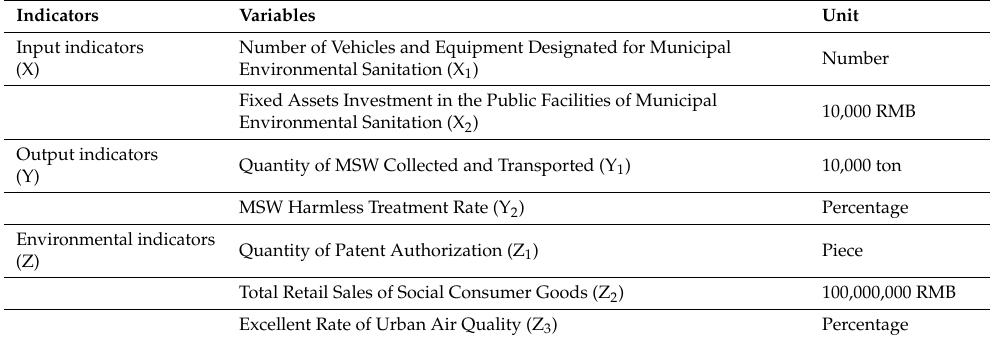
Table 1. Indicator system for measuring the efficiency of municipal solid waste (MSW)